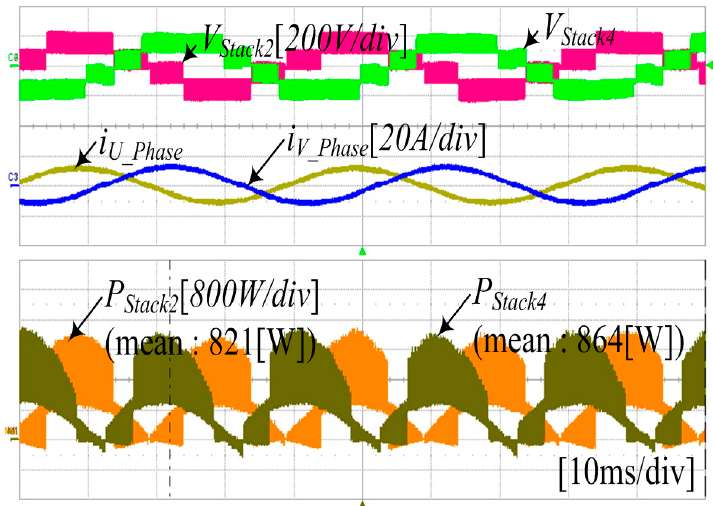
Figure 33. Experimental waveform of output voltages, phase currents, and output powers of the